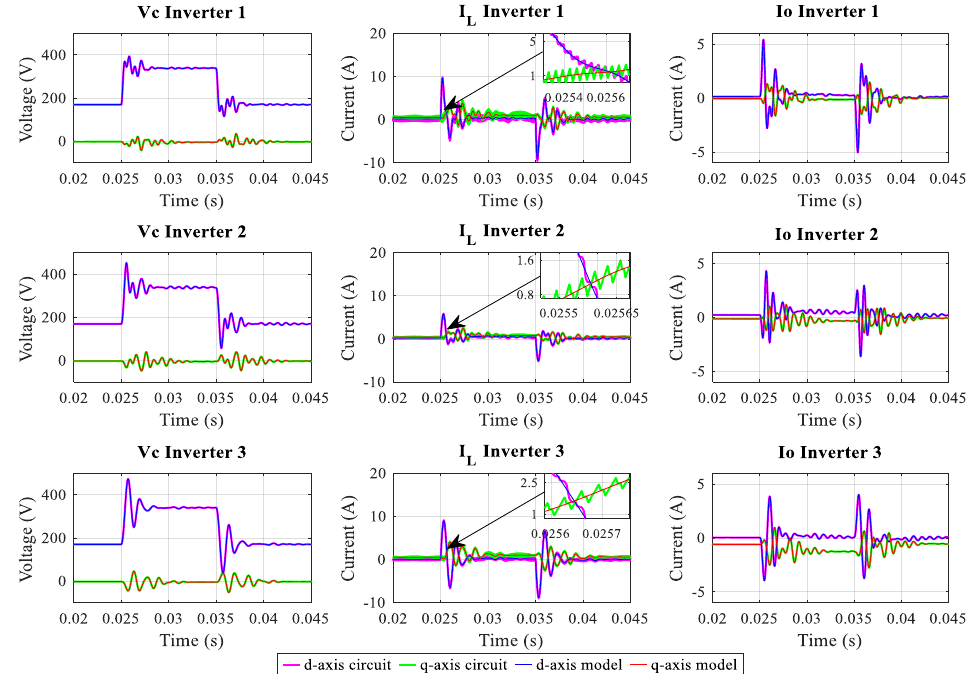
Figure 12. State-vector waveforms for the mathematical model and the circuit in islanded mode in the dq frame.